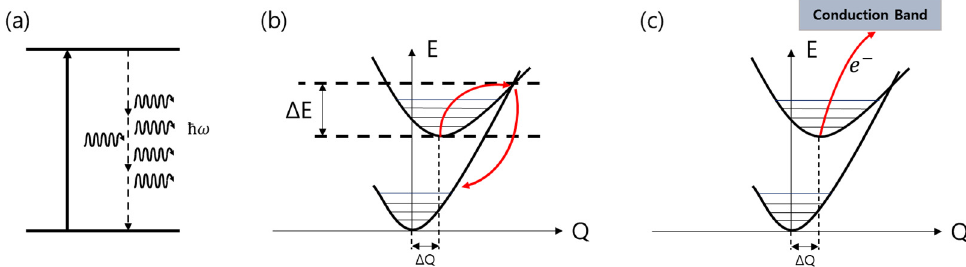
Figure 1. Thermal quenching mechanisms in inorganic scintillators: ( a ) multiphonon relaxation and single configurational coordinate diagram illustrating ( b ) nonradiative transition and ( c ) thermal ionization process. Reproduced with permission of Ref. [11].